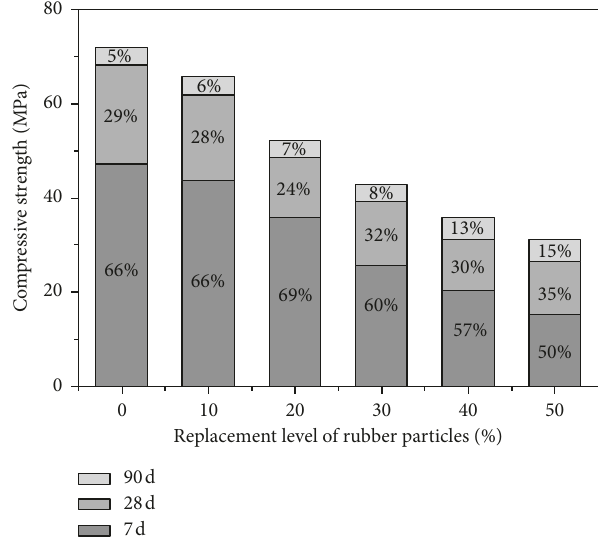
Figure 28: Compressive strength of mortar versus replacement level of rubber